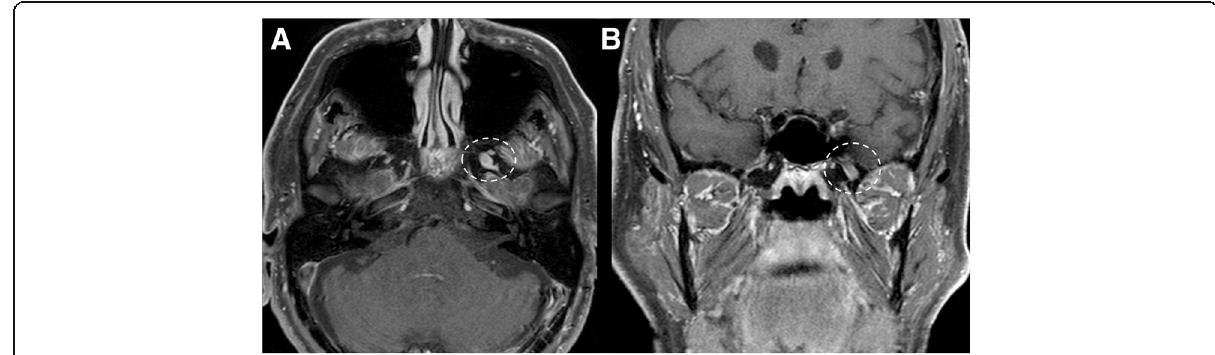
Fig. 21 Perineural spread of tumor. MRI T1-weighted post-gadolinium axial ( a ) and coronal ( b ) images. Note the enlargement and the enhancement of the mandibular branch of trigeminal nerve (V2) (dotted